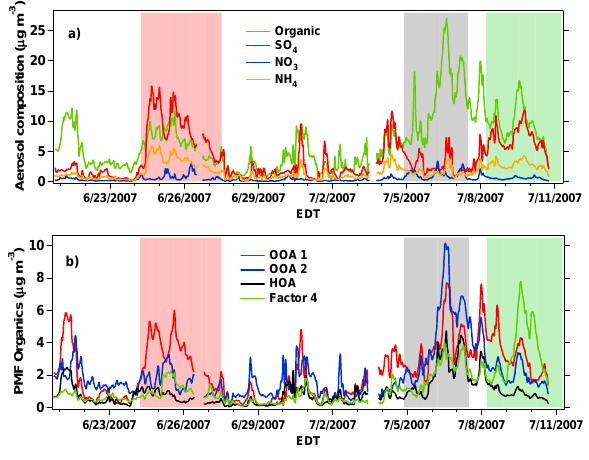
Figure 5. Time Series of AMS species in the upper frame. Factors from the Positive Matrix Factorization of the AMS organics are shown in the lower frame. Red, black and green shaded periods refers to different air mass episodes: Processed Air, Detroit Air, and Sulfate and Biogenic Air, respectively.